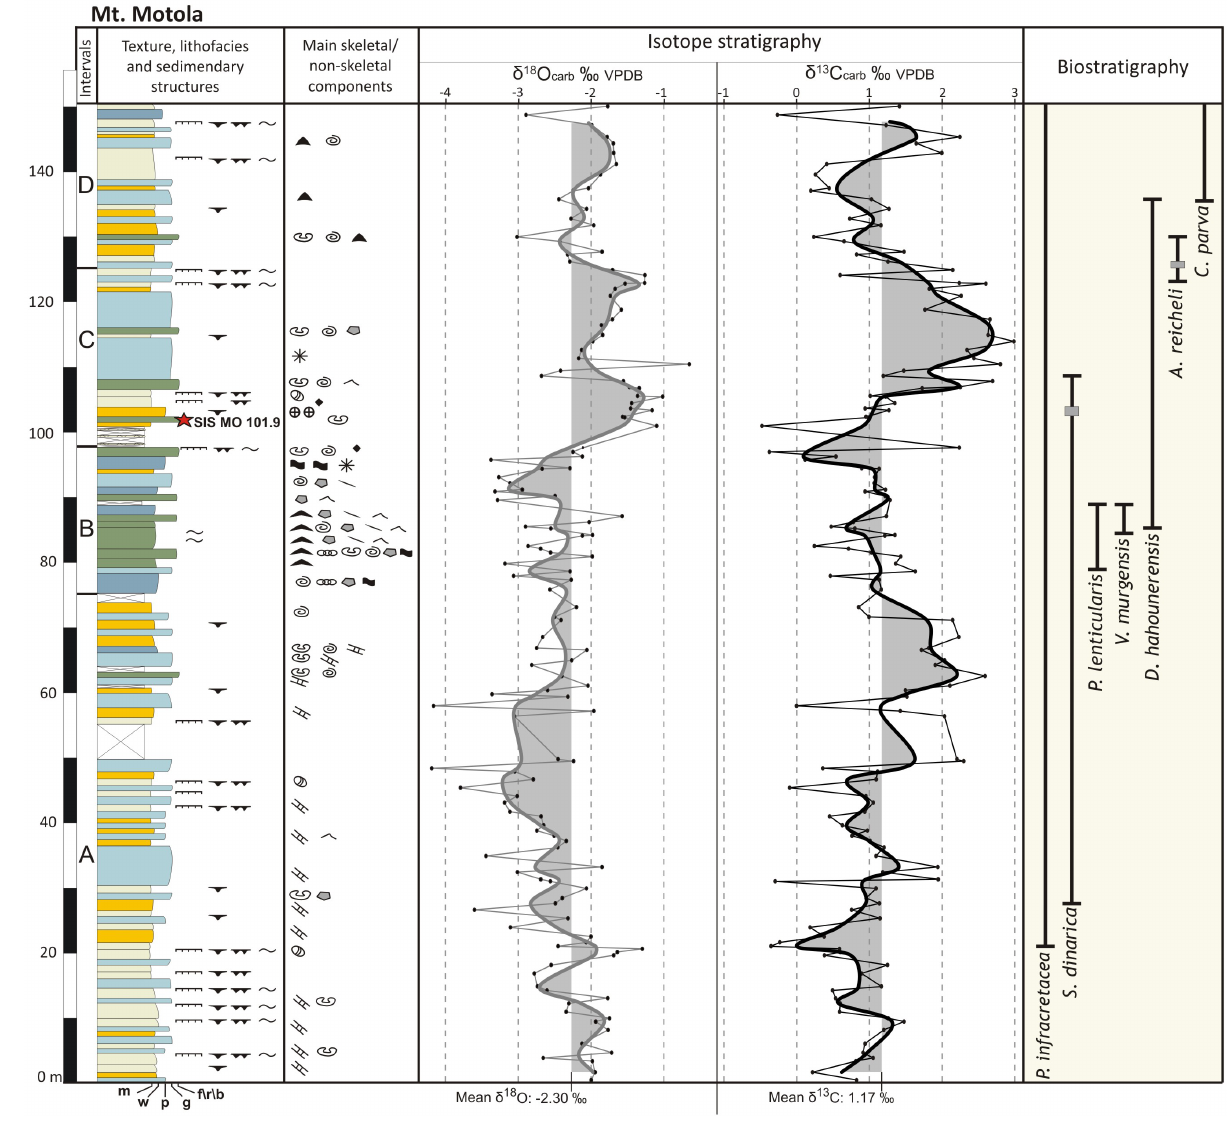
Fig. 11. Mt. Motola section: lithological–sedimentological log, isotope stratigraphy and biostratigraphy. The thick curves represent the 3-point moving averages of O- (grey) and C-isotope ratios (black). See Fig. 8 for a key to colours, patterns and